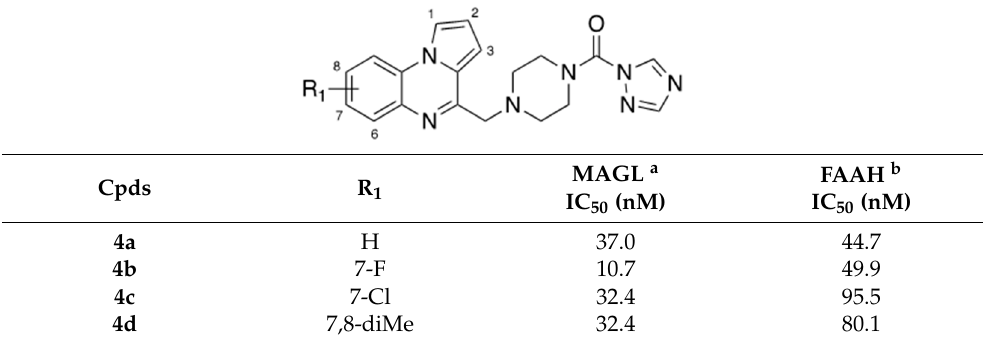
Table 3. IC 50 values on FAAH and MAGL enzyme for pyrroloquioxaline-based dual inhibitors.